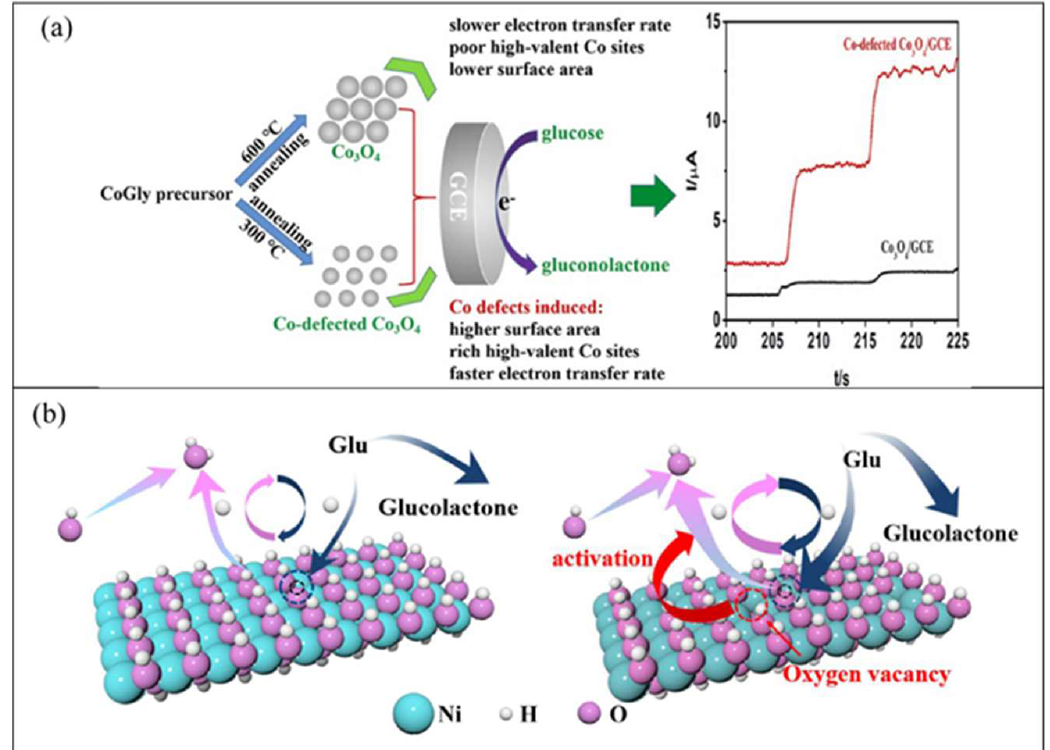
Figure 13. Schematic of ( a ) Co 3 O 4 and Co-defected Co 3 O 4 modification strategies and the amperometric performance with glucose addition. Reprinted with permission from ref. [207]; Copyright 2022 Elsevier. ( b ) Mechanism for glucose detection in pristine Ni(OH) 2 and defect-Ni(OH) 2 . Reprinted with permission from ref. [224]; Copyright 2021 Elsevier. Table 7. Summary of the non-enzymatic glucose biosensors based on metal-based nanomaterials, metal oxide-based nanomaterials and nanohybrid/nanocomposite. Electrode Nanomaterials Modified Applied Potential Modification Electrode Alloying–dealloying via electrochemical deposition